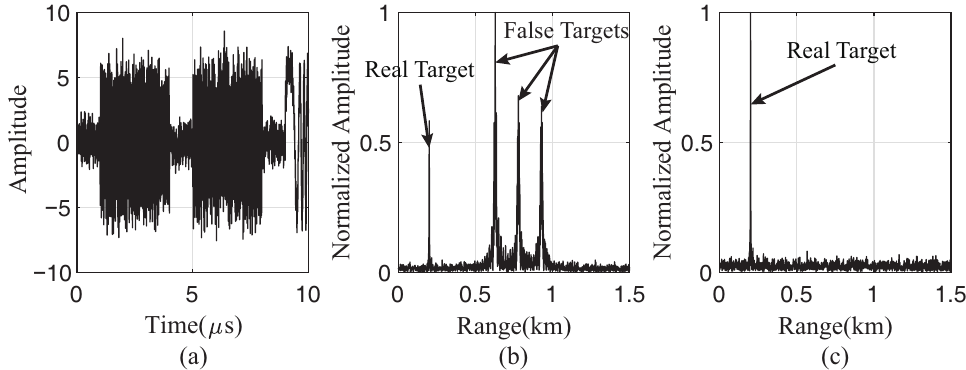
Figure 5. Simulation results of TMF for ISPRJ. ( a ) The echo signal with ISPRJ; ( b ) pulse compression of the echo signal; ( c ) pulse compression of echo signal after TMF.